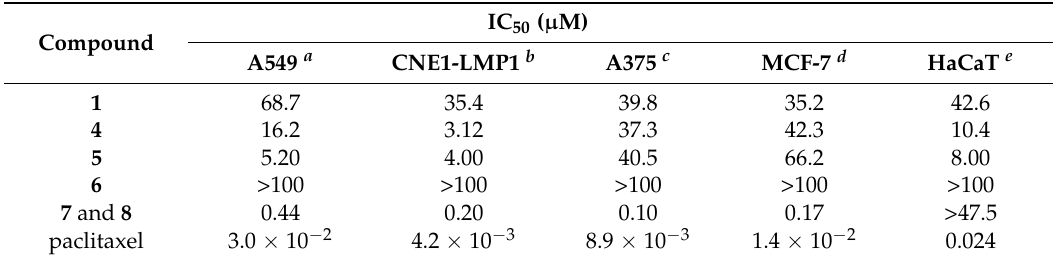
Table 2. Cytotoxicity of Compounds 1 , 4 – 8 Against Human Tumor Cell Lines.